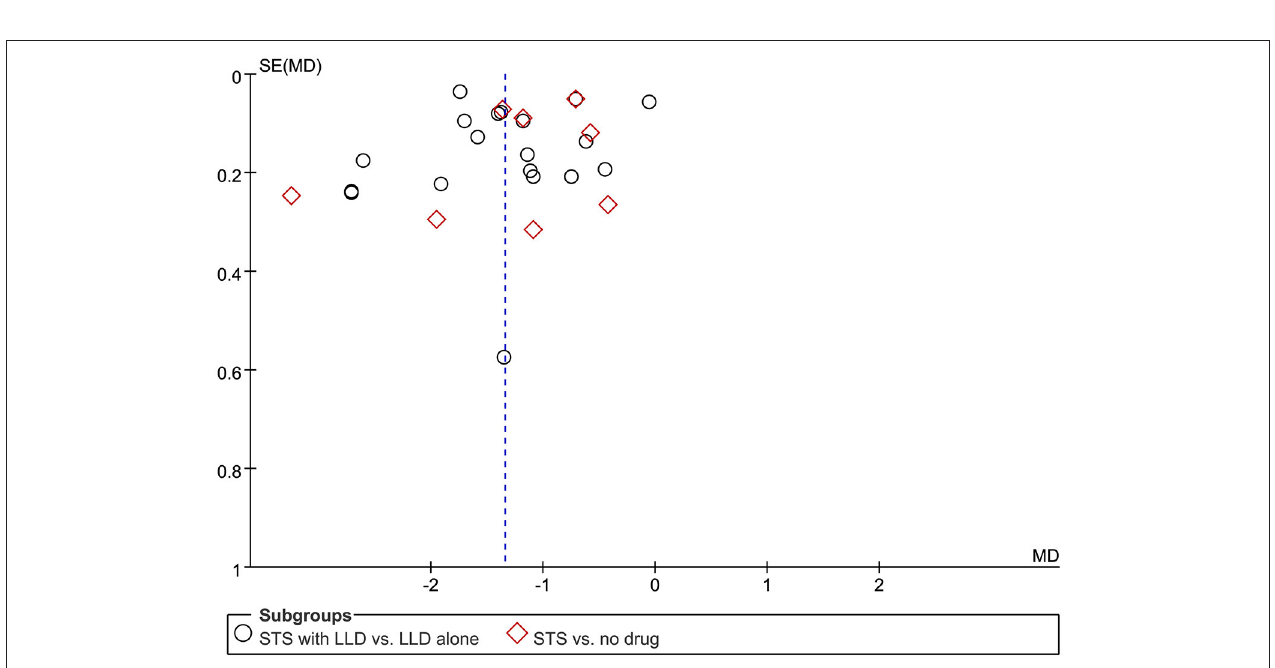
FIGURE 8 | Funnel plot of comparison: STS vs. non-STS in